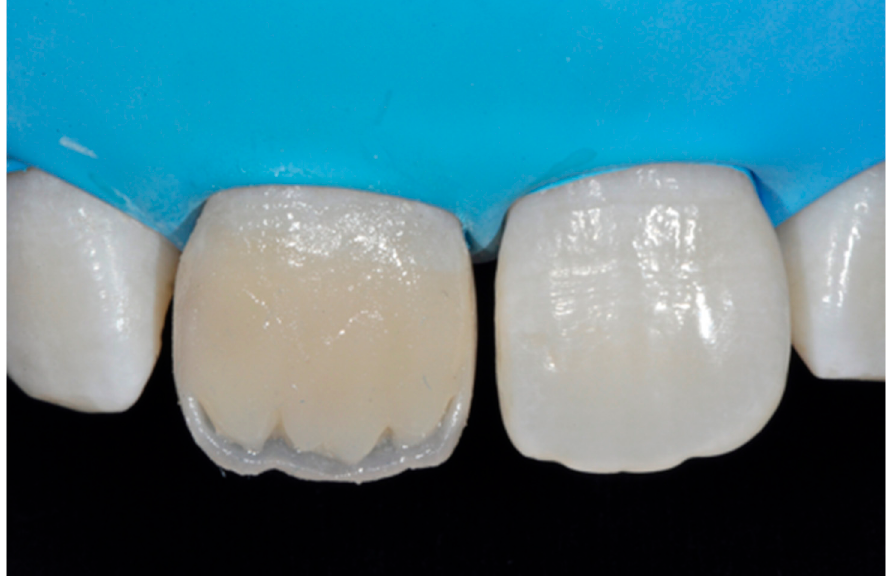
Figure 11. Dentinal body completed. Reprinted from Restauri diretti nei settori anteriori, G. Paolone, S. Scolavino, © 2021, with permission from Quintessence Publishing Italy.